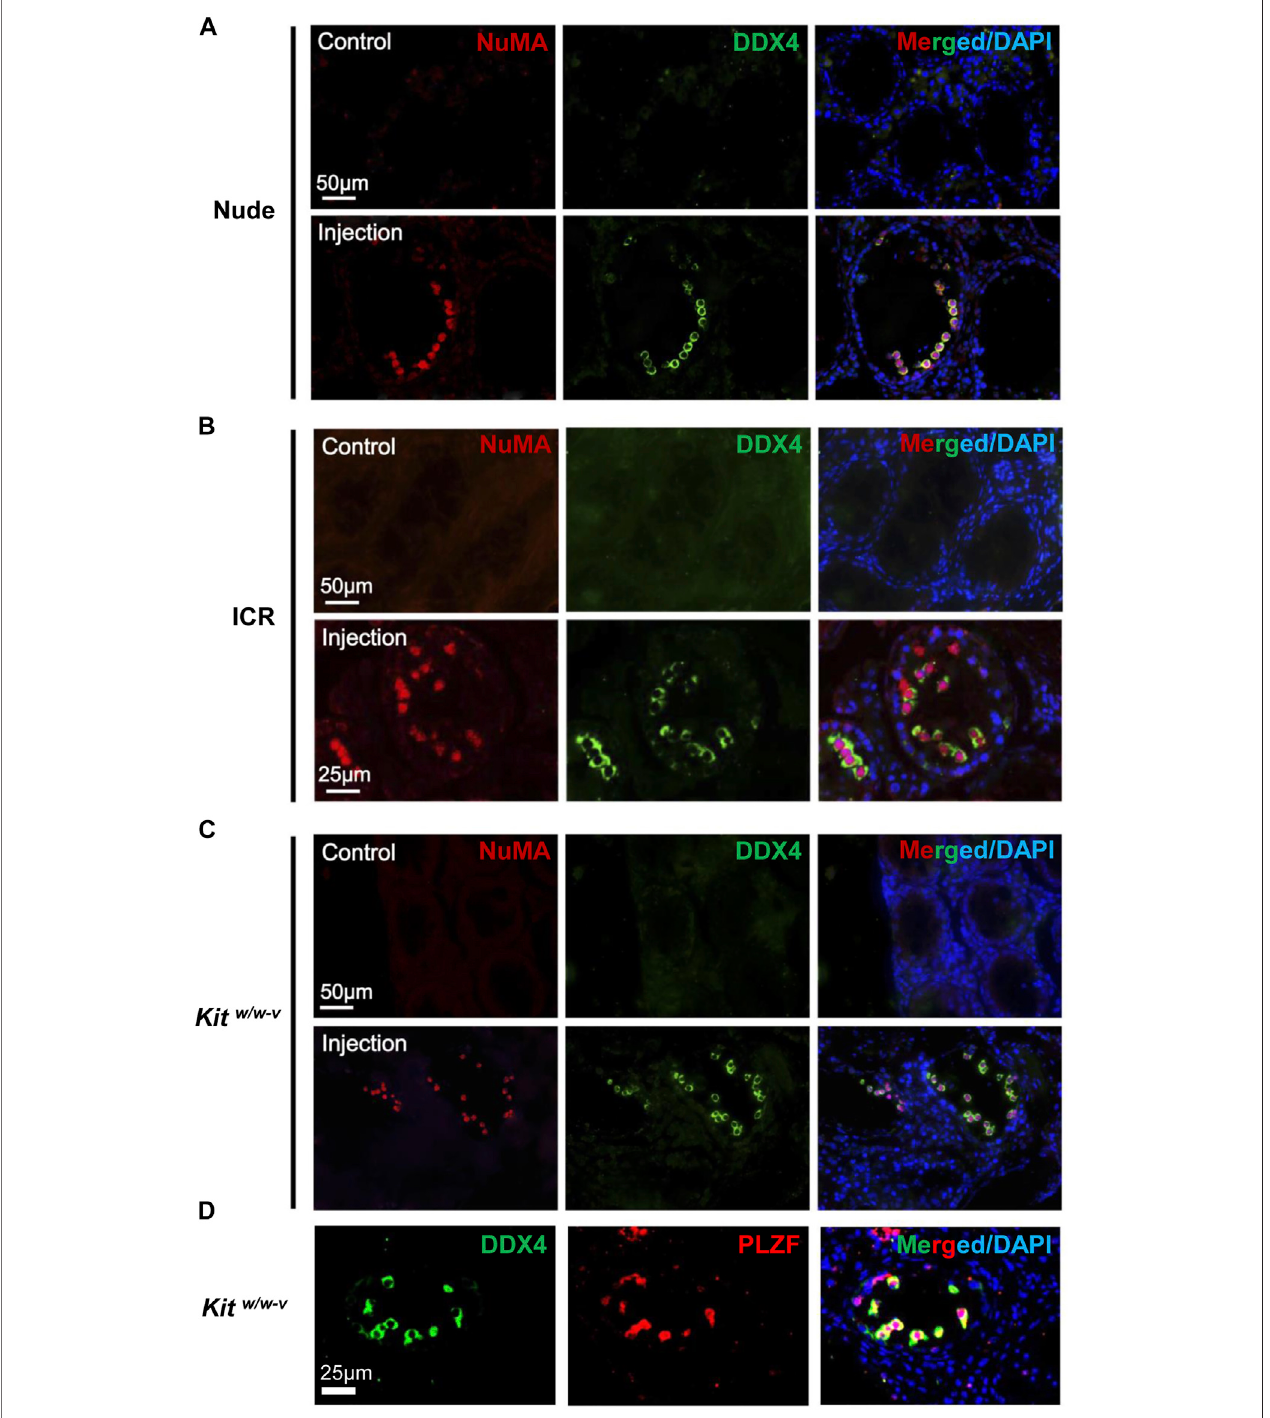
FIGURE 3 | In vivo developed human spermatogonia engrafted into testes from both immune-de fi cient and immune-competent mice. (A – C) IHF assays were performedonnude,ICR,and Kit w/w-v testesat6 weeksposttransplantation,withNuMAandDDX4antibodies,co-stainedwithDAPI. (D) IHFassayswereconductedon injected Kit w/w-v testes with antibodies against PLZF and DDX4, counterstained with DAPI. Nude and ICR mice at age 6 weeks were injected intraperitoneally with 40 mg/kgbusulfanandweresubsequentlyusedasrecipientsafter6weeks. Kit w/w-v miceat12-weekoldwereusedasrecipients.About30,000humangermcells from OA patients were injected per testis for xenotransplantation. The contralateral testis in the same mouse with mock PBS injection was used as a control. In total, 5 nude mice, 5 ICR mice, and 6 Kit w/w-v mice were injected.